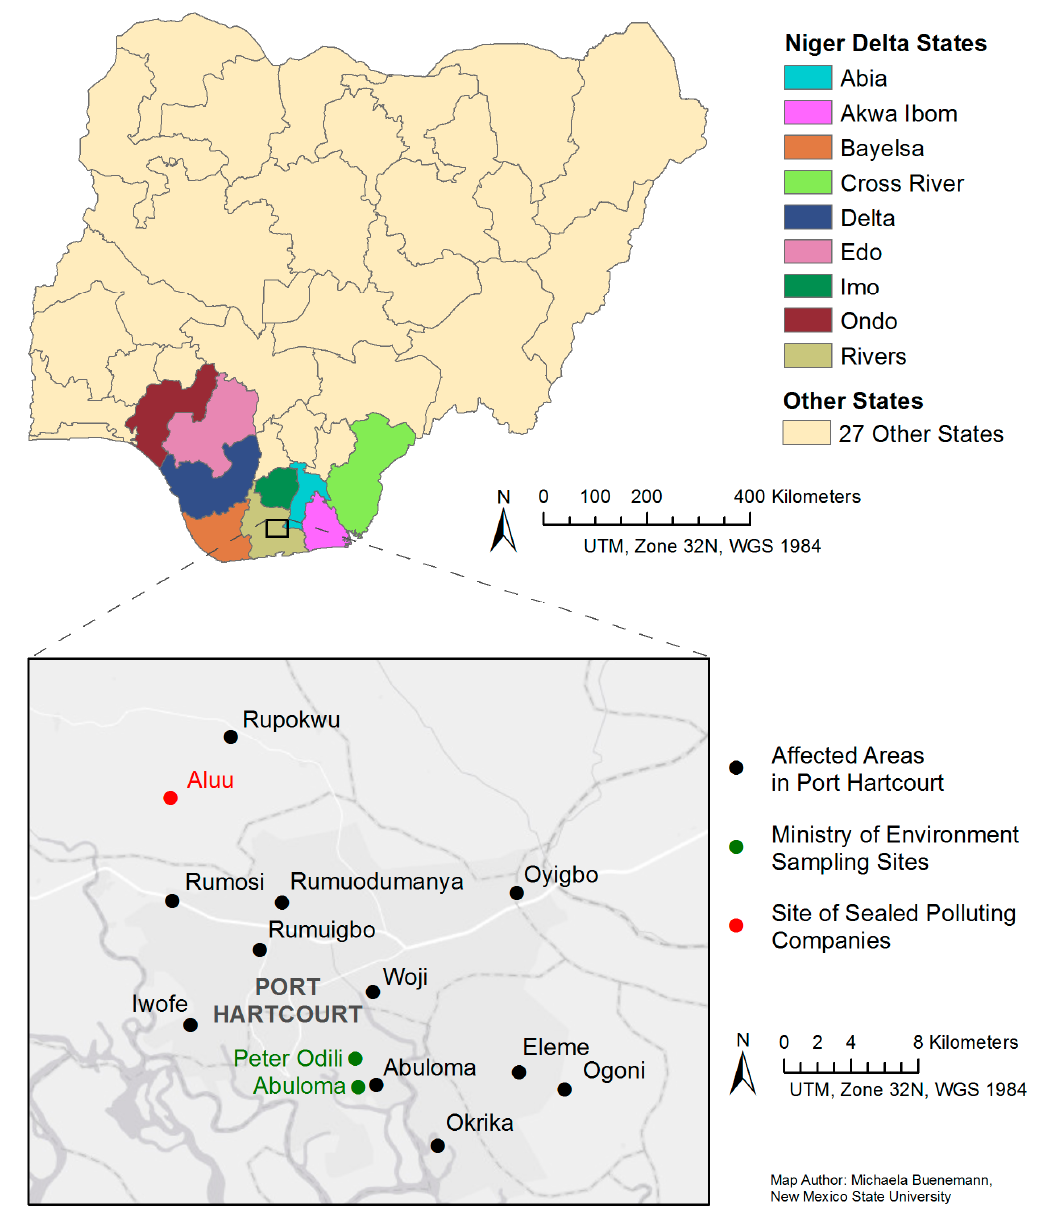
Figure 1. Map showing soot-polluted areas, Ministry of environment sampling sites, and the location of sealed companies in Aluu.